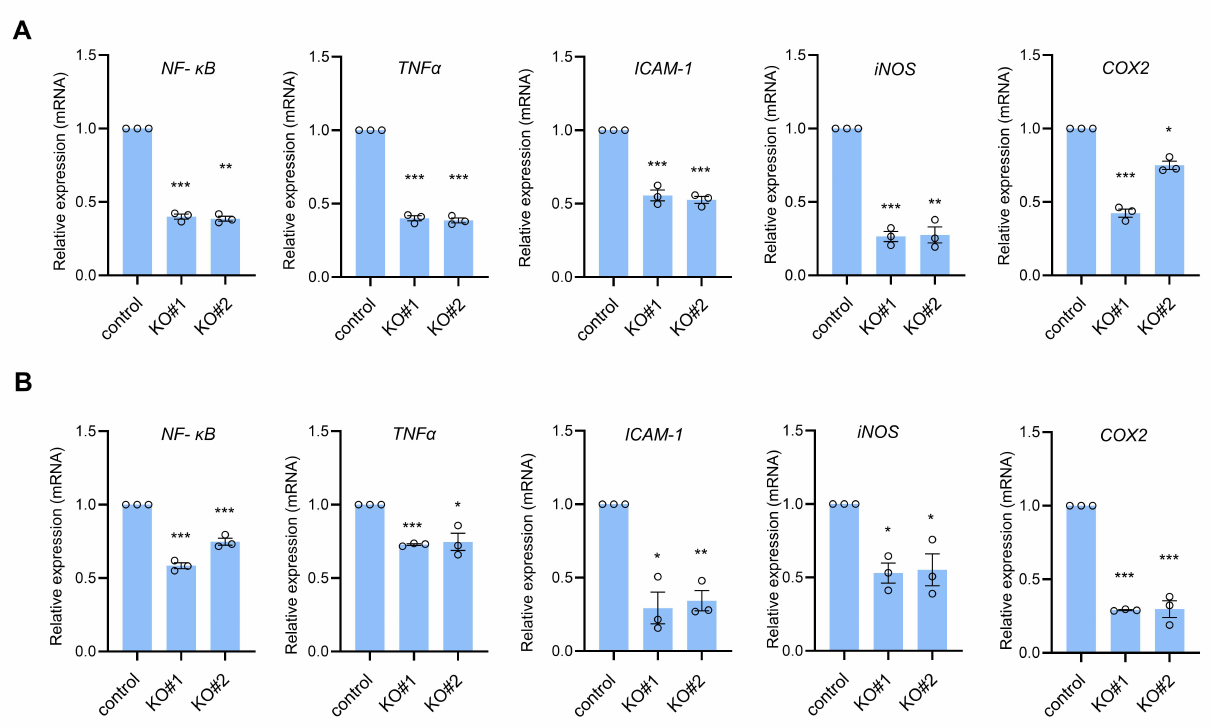
Figure 2. CTRP1 knockout cells show decreased NF- κ B expression and NF- κ B-dependent transcrip- tion. ( A ) mRNA expression levels of NF- κ B, TNF α , intercellular adhesion molecule 1 (ICAM-1), inducible nitric oxide synthase (iNOS), and cyclooxygenase 2 (COX2) were measured using quantita- tive reverse transcription-polymerase chain reaction (qRT-PCR) in A549 cells. ( B ) mRNA expression levels of NF- κ B, TNF α , ICAM-1, iNOS, and COX2 were measured using qRT-PCR in HCT116 cells. The means and standard deviations are shown. Control vs. knockout cells: * p < 0.05; ** p < 0.01; *** p <